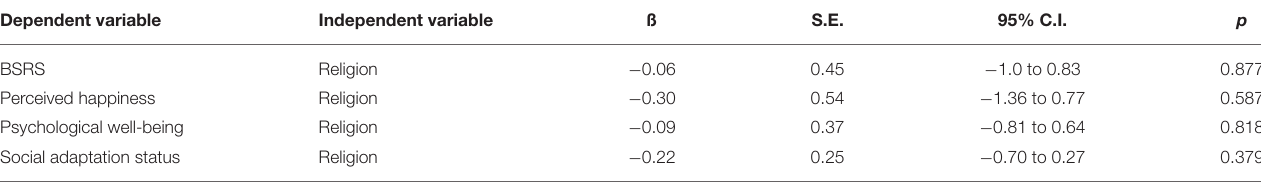
TABLE 2 | Generalized equation estimation model of the association of religion on the mental health and level of happiness of healthcare workers over time.